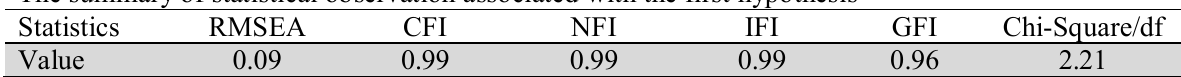
Statistics RMSEA CFI Value